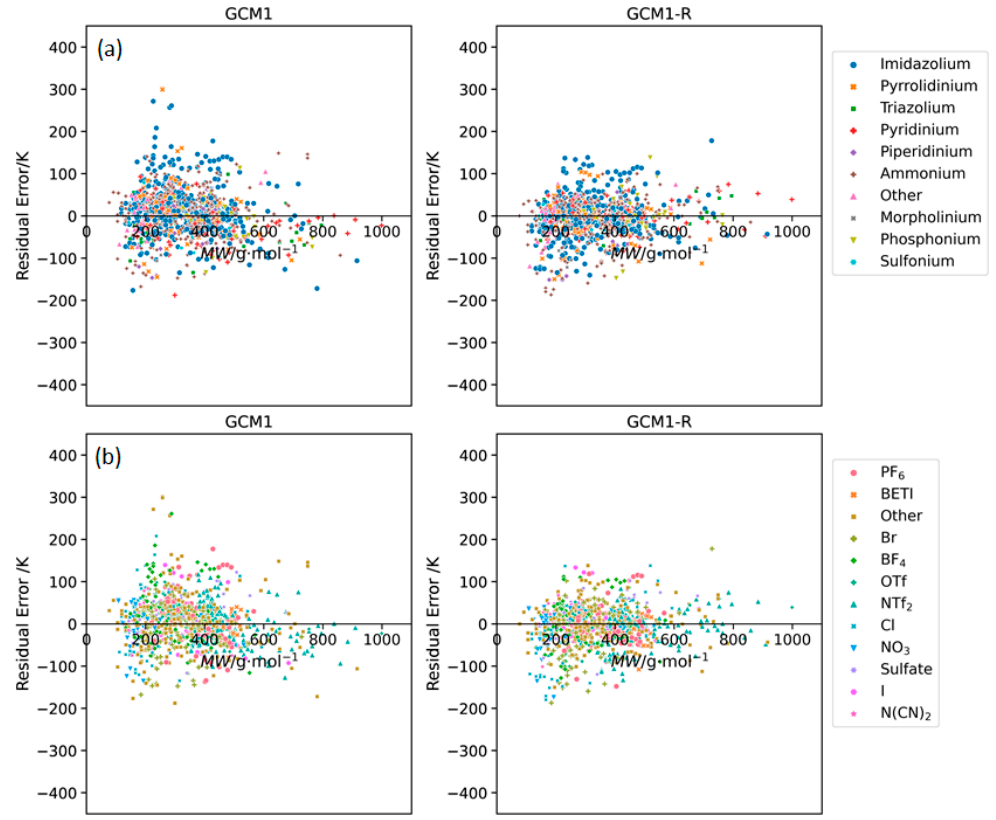
Figure 8. Residual plots of error versus IL molecular weight obtained using GCM1 and GCM1-R to estimate melting points for ILs containing the major ( a ) cation and ( b ) anion types.